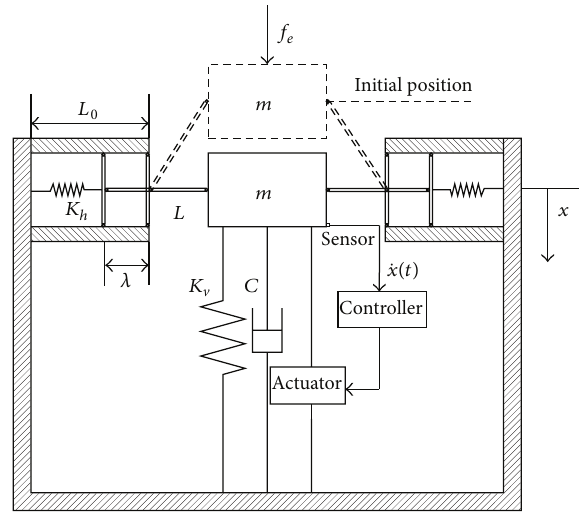
Figure 1: Scheme of a HSLDS vibration isolator with time-delayed cubic velocity feedback